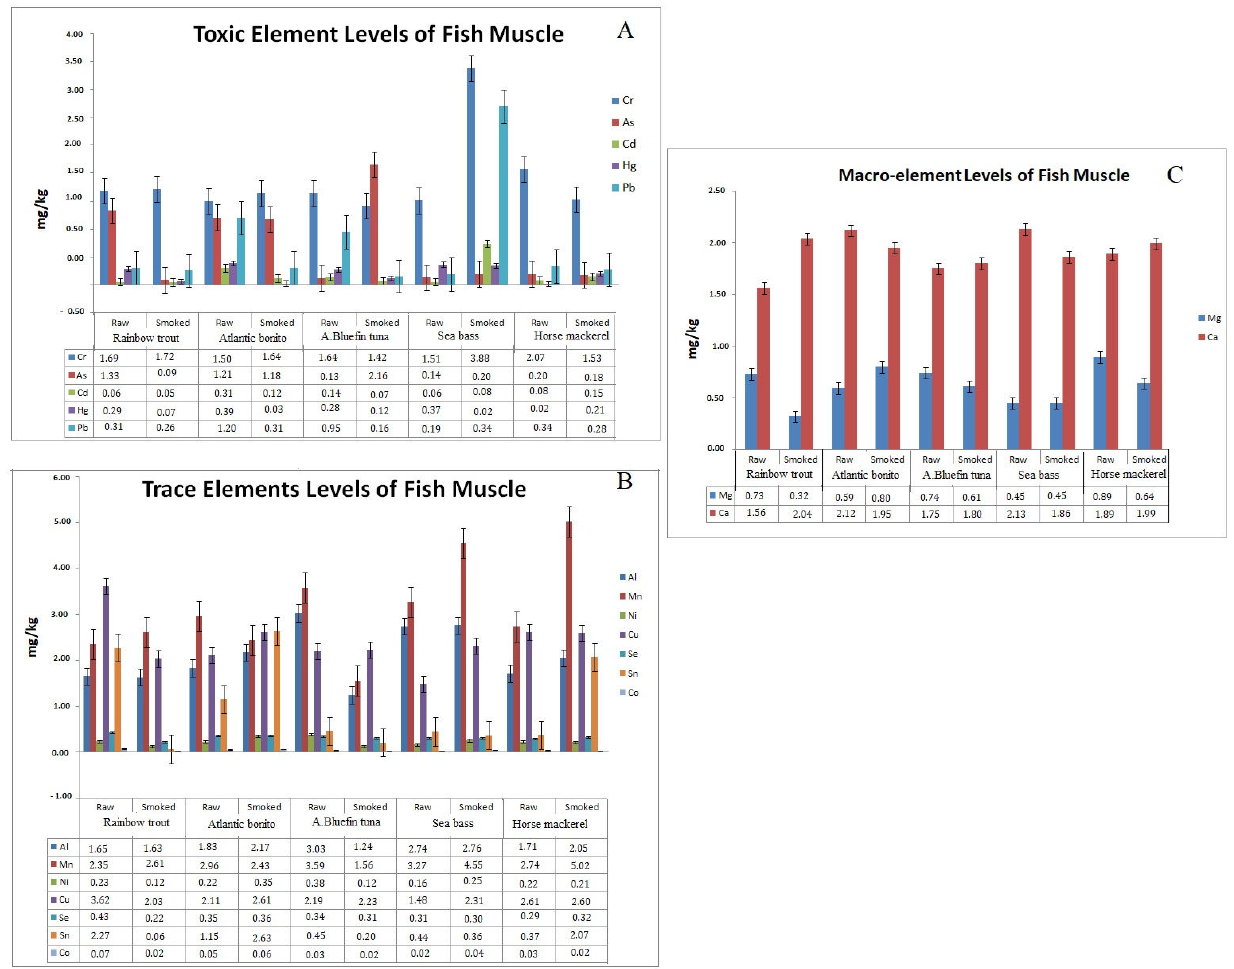
Figure 2. Elemental composition of fresh and smoked sample ( A ): toxic element level of both fresh and smoked samples, ( B ): trace element level of both fresh and smoked sample, ( C ): macro-element level of both fresh and smoked